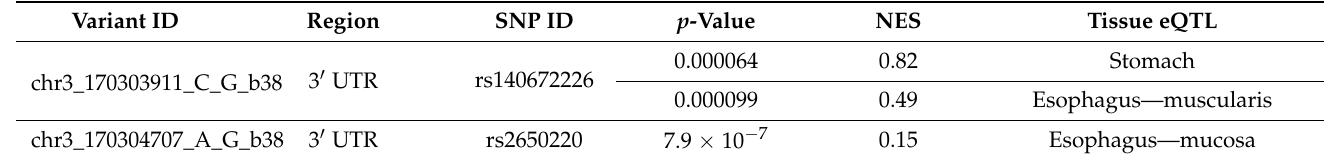
Figure 3. ( a , b ) Violin plots of SNP rs140672226 and ( c ) rs2650220 for single tissue eQTLs analysis through GTEx. Table 2. Single tissue eQTL association of UTR variants taken from GTEx portal with NES and p